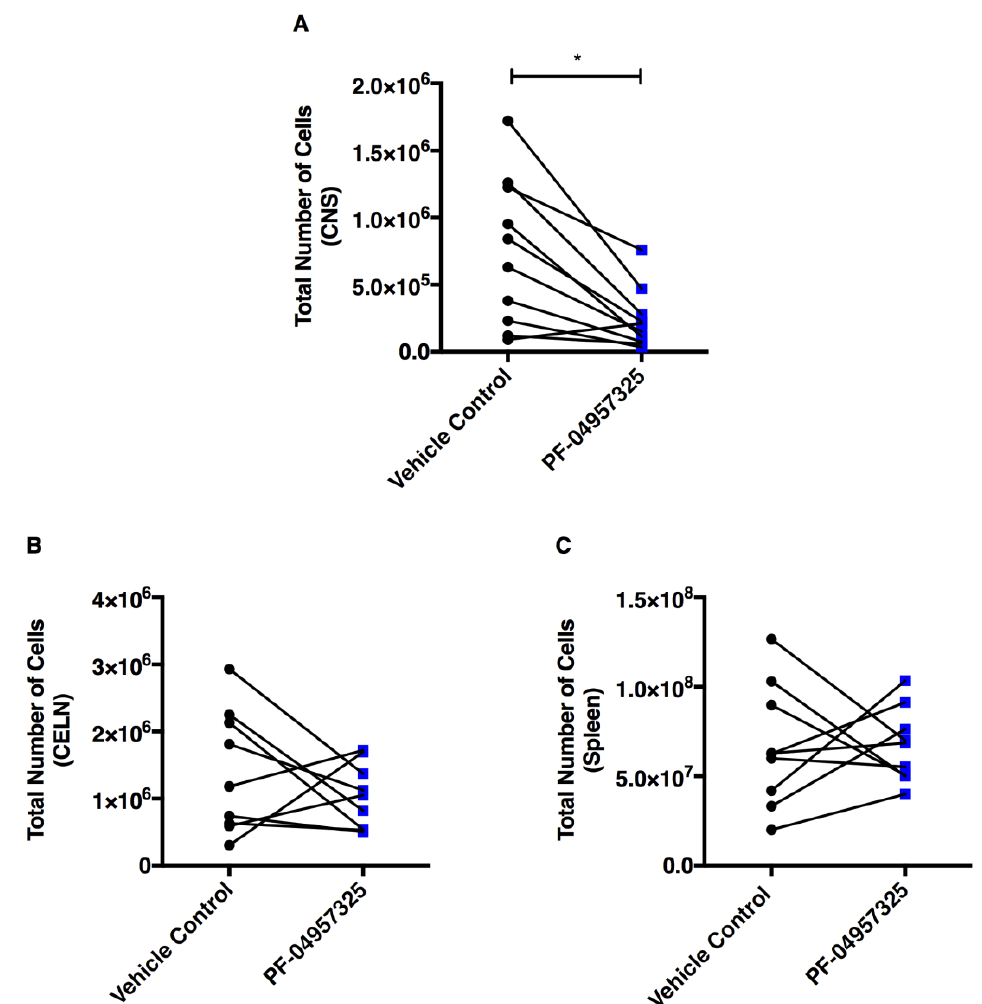
Figure 3. Treatment with PF-04957325 suppresses leukocyte infiltration into the spinal cord. Mice with EAE scores of at least 1 were treated with the vehicle control or PF-04957325 three times daily, for 6 to 13 days. The data represent the total number of mononuclear cells in the spinal cord (CNS) after Percoll gradient isolation ( A ) ( n =10 mice per group, five independent experiments; * p = 0.015)), in cervical lymph nodes (CELN) ( B ), and spleens ( C ) ( n = 9 mice per group, mean ± SEM of four independent experiments) counted by trypan blue exclusion assay. The horizontal lines indicate comparisons between each pair of vehicle control- or PF-04957325-treated mice enrolled in the treatment regimen at the same time.